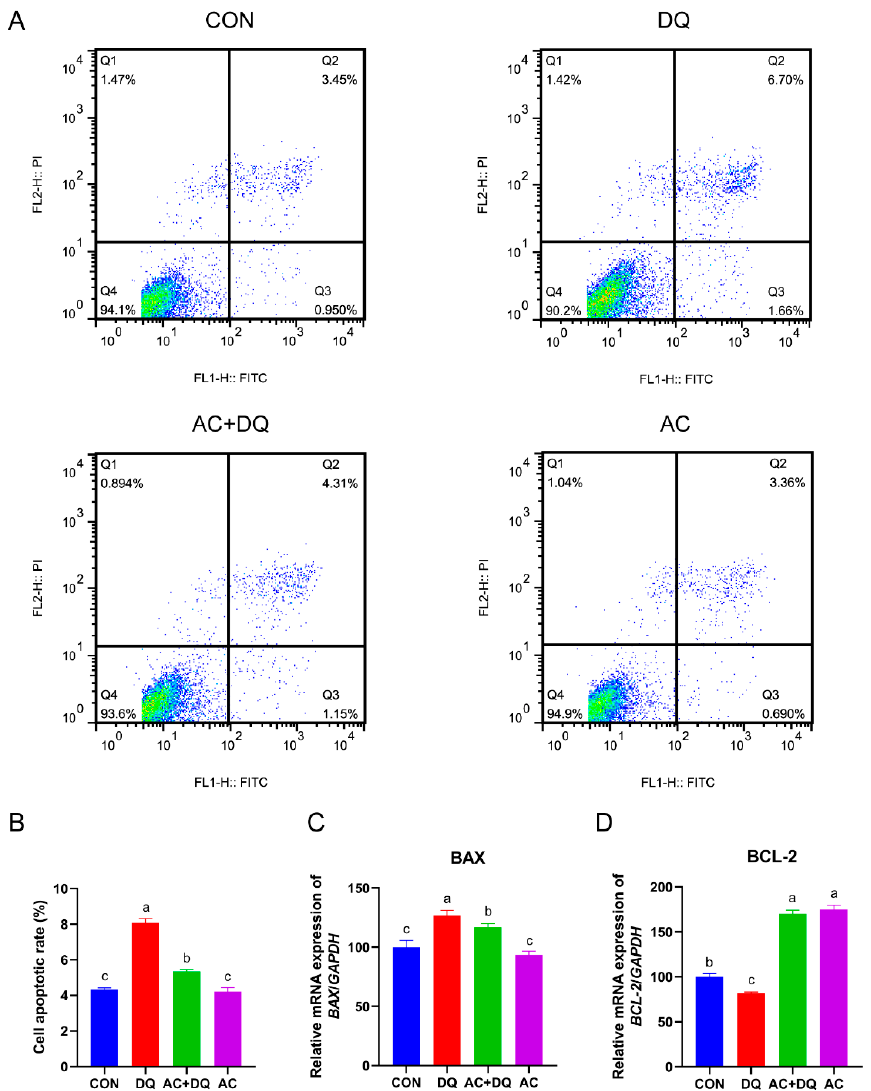
Figure 5. Effect of acidifiers on the apoptosis of IPEC-J2 cells induced by diquat. ( A ) Annexin V-FITC/PI apoptosis assay. Apoptotic cell rates were detected with a FITC annexin V-FITC/PI apoptosis kit, and then analyzed by flow cytometry. ( B ) The cell apoptosis of IPEC-J2 cells. ( C ) The mRNA expression level of BAX was determined using a qRT-PCR. ( D ) The mRNA expression level of BCL-2 was determined using a qRT-PCR. CON, cells without being treated; DQ, cells were only treated by 1150 μ M of diquat for 6 h; AC + DQ , cells were pretreated by 0.005% acidifier for 4 h and were then treated by 1150 μ M of diquat for 6 h. AC, cells were only treated by 1150 μ M of acidifier for 6 h. All values were represented as means ± SEM ( n = 6). Different superscript letters denote a statistically significant difference between groups ( p < 0.05), while same letters denote no significant difference.